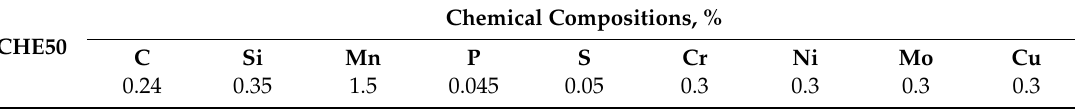
Table 2. Chemical compositions of filler